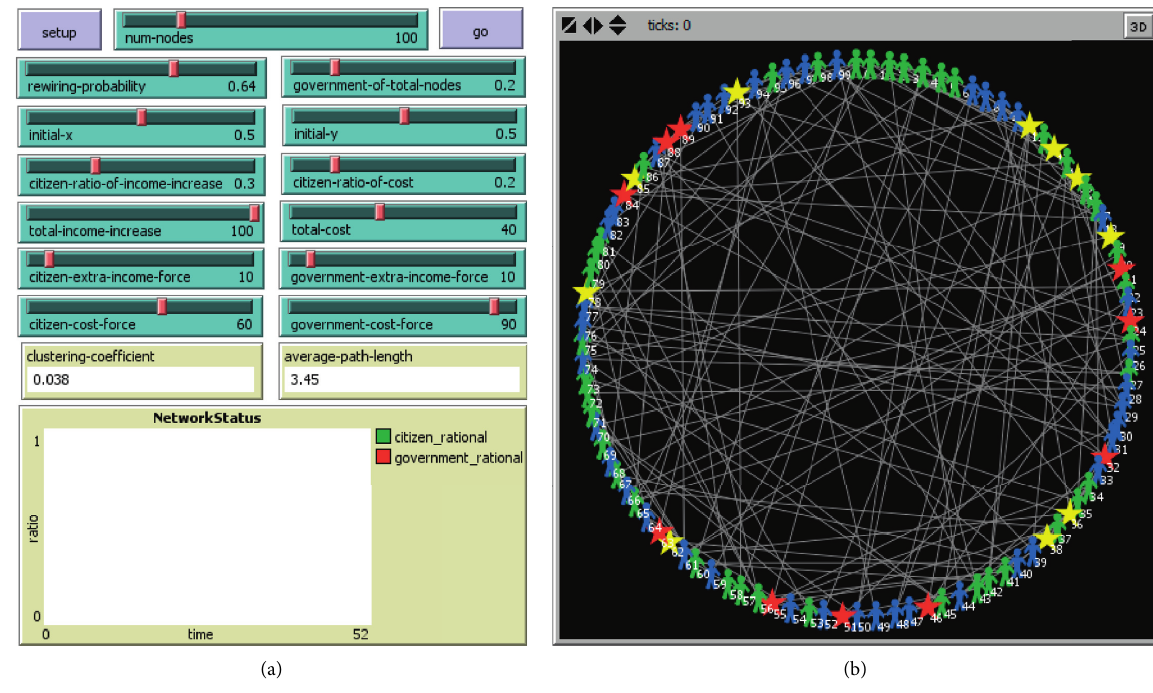
Figure 3: The initial state on the WS small-world resistance. “Government-extra-income-force” indicates the additional revenue from the government’s tough control.